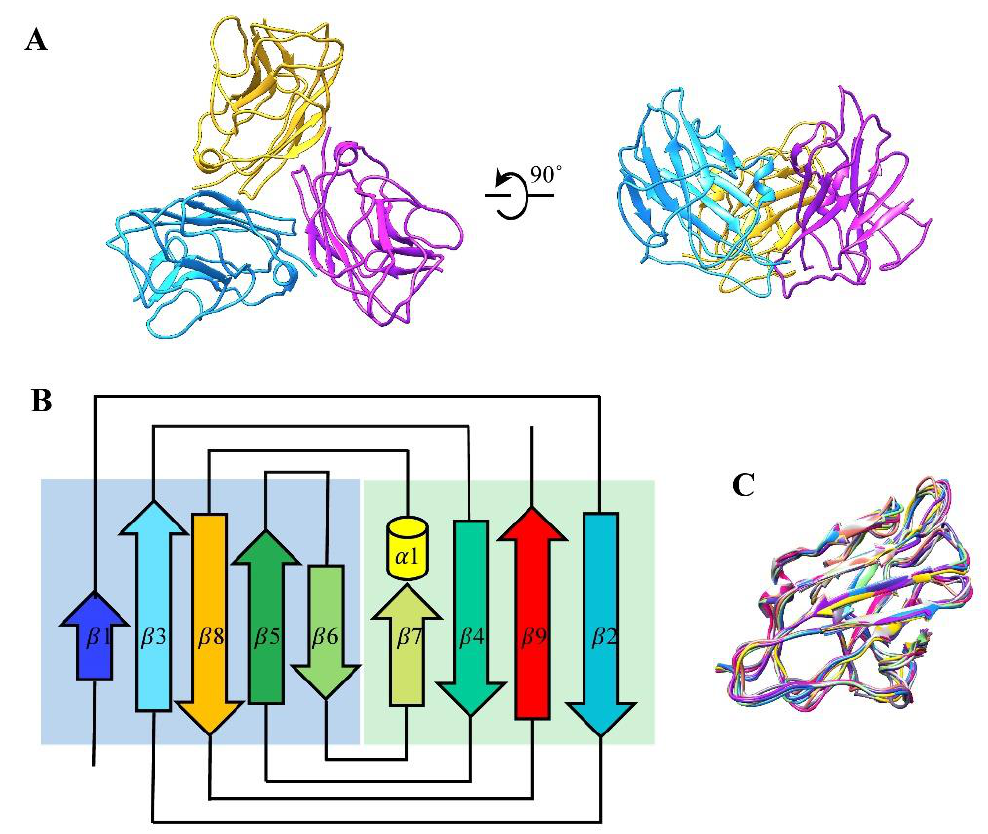
Figure 3. Structure of CPs. ( A ) Ribbon model of the CP trimer gp1 shown in top and side views. ( B ) Topological diagram of gp1. The color scheme is the same as in Figure 1F. ( C ) Superimposition of the nine CP monomers colored differently, with negligible differences.